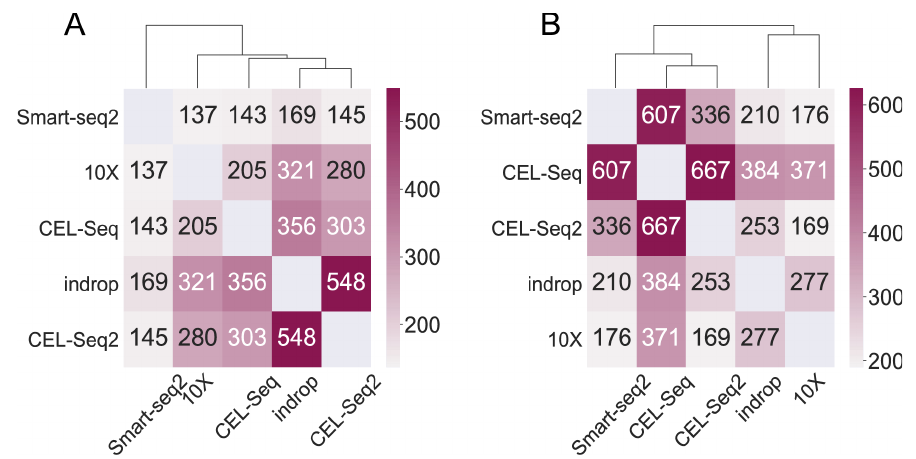
Fig 6. (A) Number of overlapping genes among the top 1000 HVGs of the data from five different technologies, and (B) Highly interrelated gene selected by ADC between each pair of these datasets (FDR = 0.01). Unsupervised hierarchical clustering was performed with the reciprocal value of the number in both